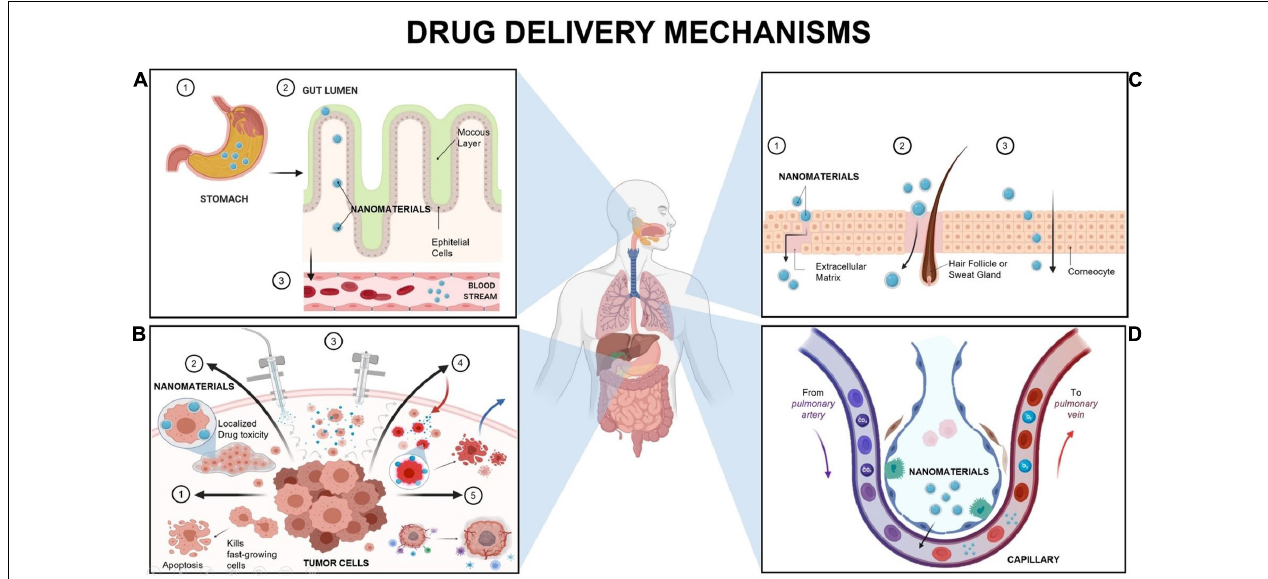
FIGURE 1 | Principal Mechanism of Nanomaterials delivery in humans. (A) Oral delivery: The nanomaterial envelope plays the most crucial role as a protective agent. It allows the nanomaterials to pass from the stomach to the small intestine and reach the systemic circulation. (B) Intraperitoneal (IP) Delivery: The most common alternatives are Nanomaterials (NMs) loaded with chemotherapeutics [B1] to ensure the prevalence of the chemotherapeutics onto the target zone and induce apoptosis of fast-growing cancer cells (Dakwar et al., 2017). Secondly, depot systems for sustained release of nanomaterials (such as hydrogels) [B2], where the agents have localized toxicity (Van de Sande et al., 2020). Also, Pressurized intraperitoneal aerosol chemotherapy (PIPAC) [B3], in which nanomaterials are released as close to the tumor as possible, and then extracted to avoid healthy cells damage; followed by Hyperthermic IP chemoperfusion (HIPEC) [B4], which uses heated chemotherapy (107 degrees) with NMs to reduce cancer recurrence (Carlier et al., 2017; Alyami et al., 2019; Van de Sande et al., 2020). Finally, Metronomic therapy of NMs [B5], which induces the innate immune response and inhibits tumor angiogenesis (Carlier et al., 2017; Dakwar et al., 2017; Kamble et al., 2017; Alyami et al., 2019; Van de Sande et al., 2020). (C) Skin delivery: It has three alternatives to go through the stratum corneum, which are the intercellular route [C1], the appendageal route [C2], or the transcellular route [C3]. The intercellular route means to pass around the corneocytes, using the hair follicles as a pathway for drug permeation, specifically for particles around 600 µ m (Sala et al., 2018; Brunaugh et al., 2019c). On the other hand, the appendageal route is preferably for hydrophobic or high molecular-weight NMs (Brunaugh et al., 2019c). In this route, the NMs passes through the epidermis to the dermis using aqueous microchannels formed around the hair follicles, sebaceous glands, and sweat glands (Patel et al., 2018; Zhou et al., 2018). In the transcellular route, the molecule passes through the corneocytes (phospholipid membrane and cytoplasm) and lipid lamellae; and it is commonly used for polar molecules (Sala et al., 2018; Carter et al., 2019;